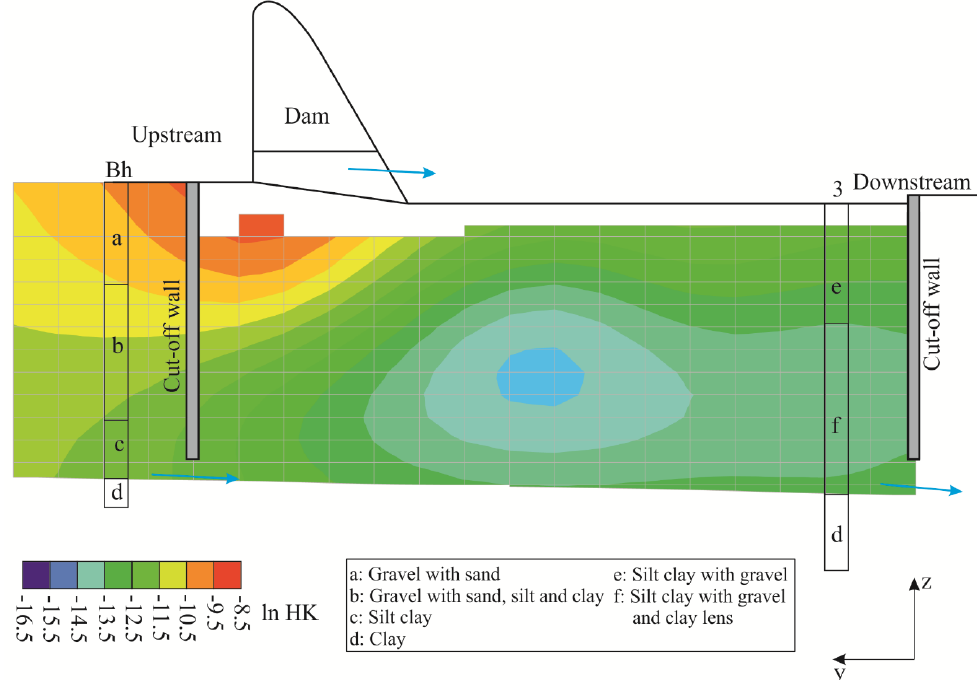
Figure 7. Estimated hydraulic conductivity field for Section AA’ of Figure 1: The results are reported in terms of natural logarithm of the parameters (ln HK) with units m/s in the physical space. Logs for borehole Bh and monitoring well 3 (see Figure 1).